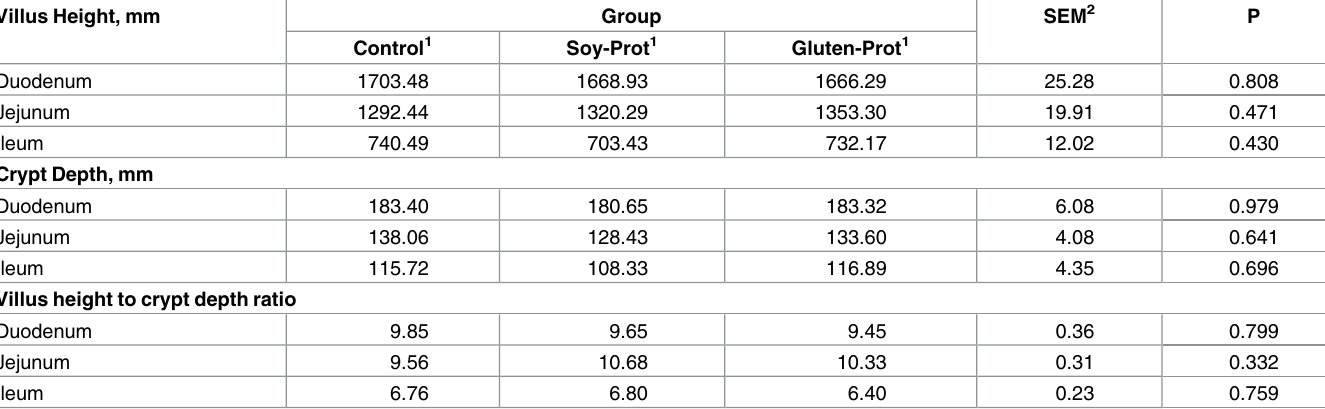
Table 9. Influence of diets on intestinal morphology (villus height and crypt depth) of broiler chickens. Villus Height,